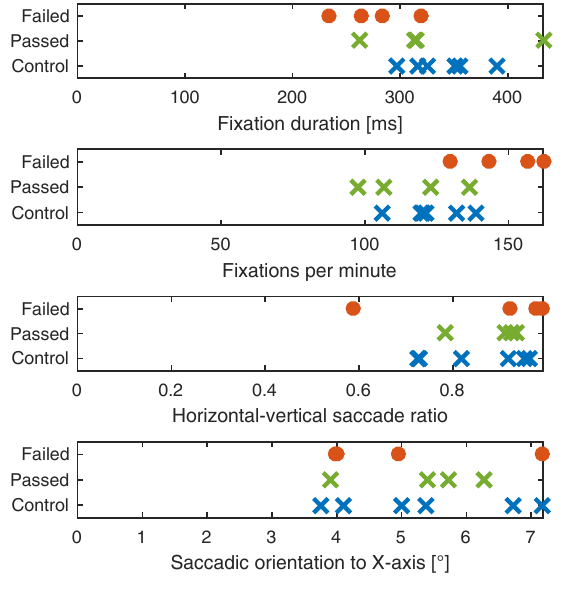
Figure 6 . Measures derived from eye tracking for the control group (HC), HVFD patients who passed the driving test (Hp) and HVFD patients who failed the driving test